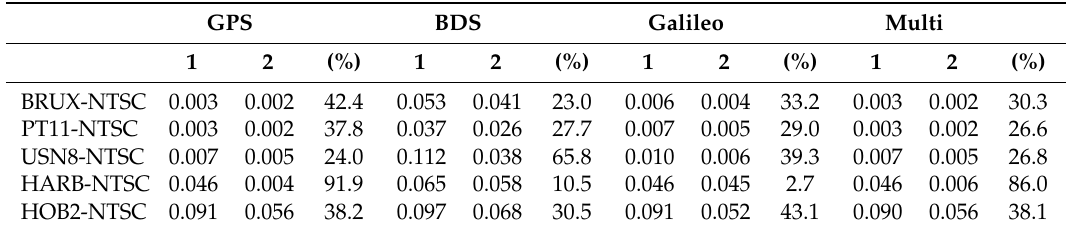
Table 7. Time link residuals of scheme1 and scheme2 compared with vondrak smoothing values using GBM products